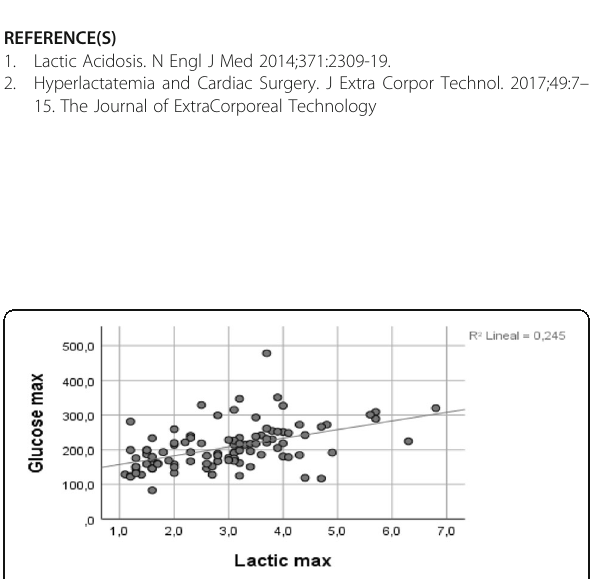
Fig. 1 (abstract 000627). See text for